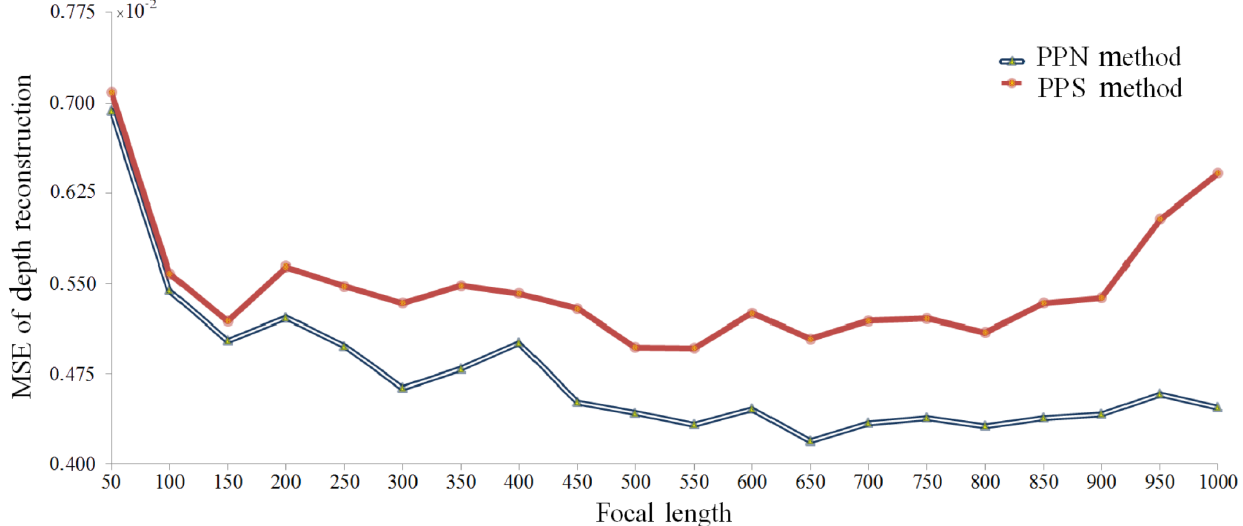
Fig. 4 Set of three test images used for our 3D reconstruction: (a) real scene used for reprojecting; (b, c) rendered images used for 3D reconstruction in presence of specularity.